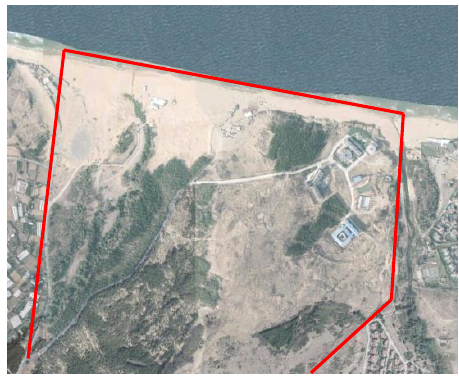
Figure 2: The Saritepe Campus in Kilyos,